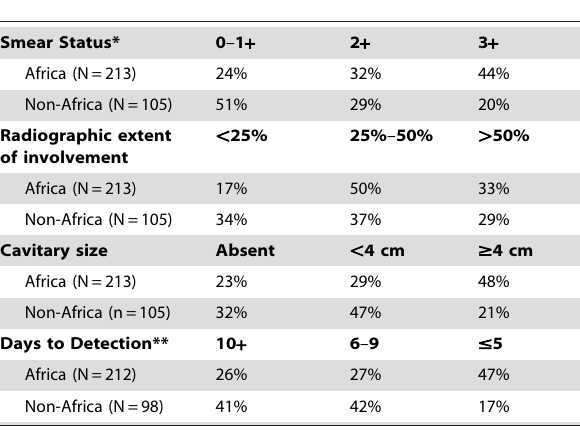
Table 1. Baseline measures of severity of disease, TBTC Study 28 protocol-correct patients, Africa vs.